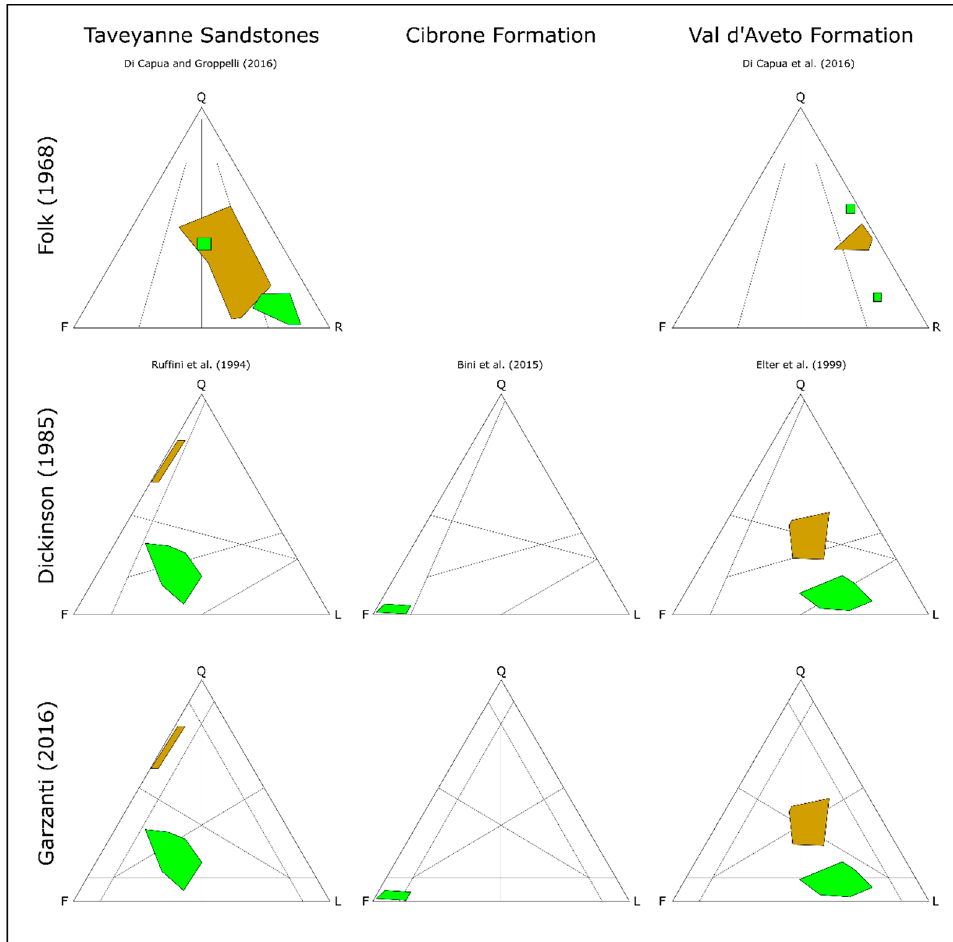
Figure 3. Ternary diagrams according to of the Formations considered in this work. Green fields group volcanogenic samples, brown fields group non-volcanic samples. Q = Quartz; F = Feldspars; L = Lithics; R = Rock Fragments.